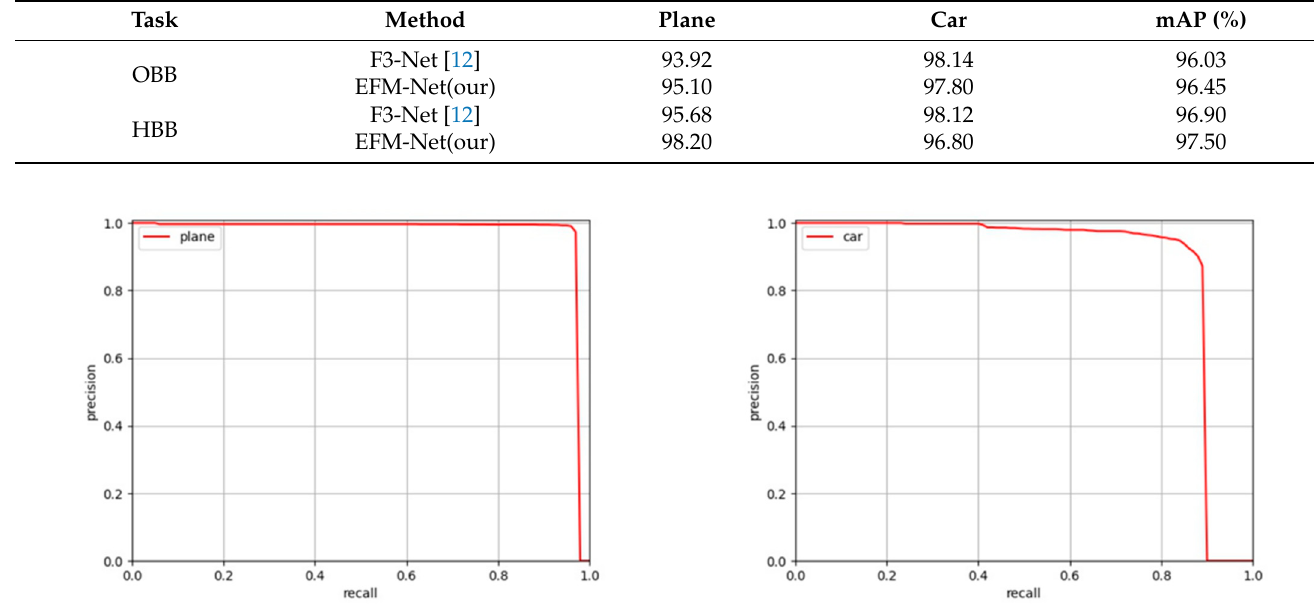
Figure 11. HBB P–R curves of different objects on the UCAS-AOD dataset with the threshold set to 0.5.